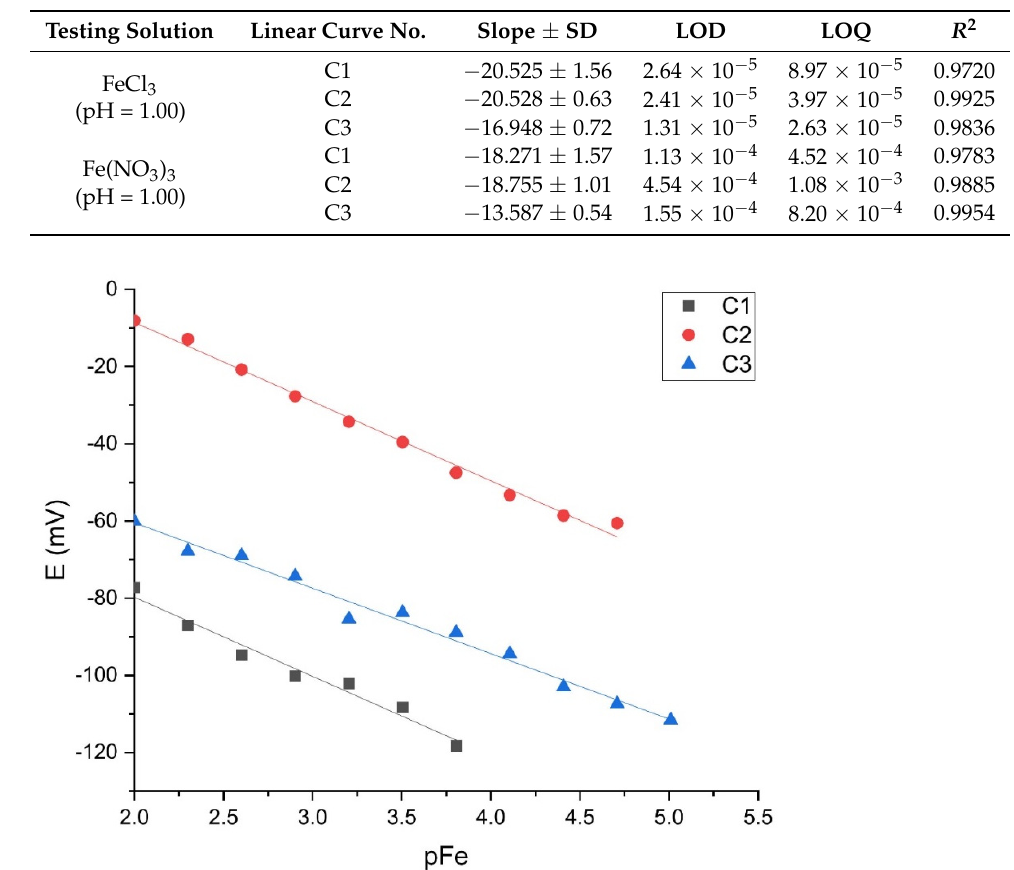
Table 2. M1 testing results in EB1.